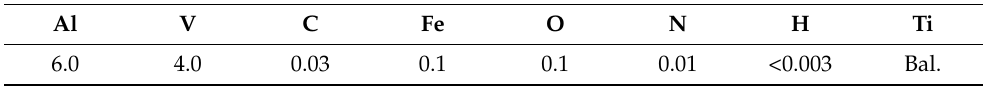
Table 1. Nominal chemical composition (wt.%) of the Arcam Ti6Al4V powder in virgin new condi- tion (P2).